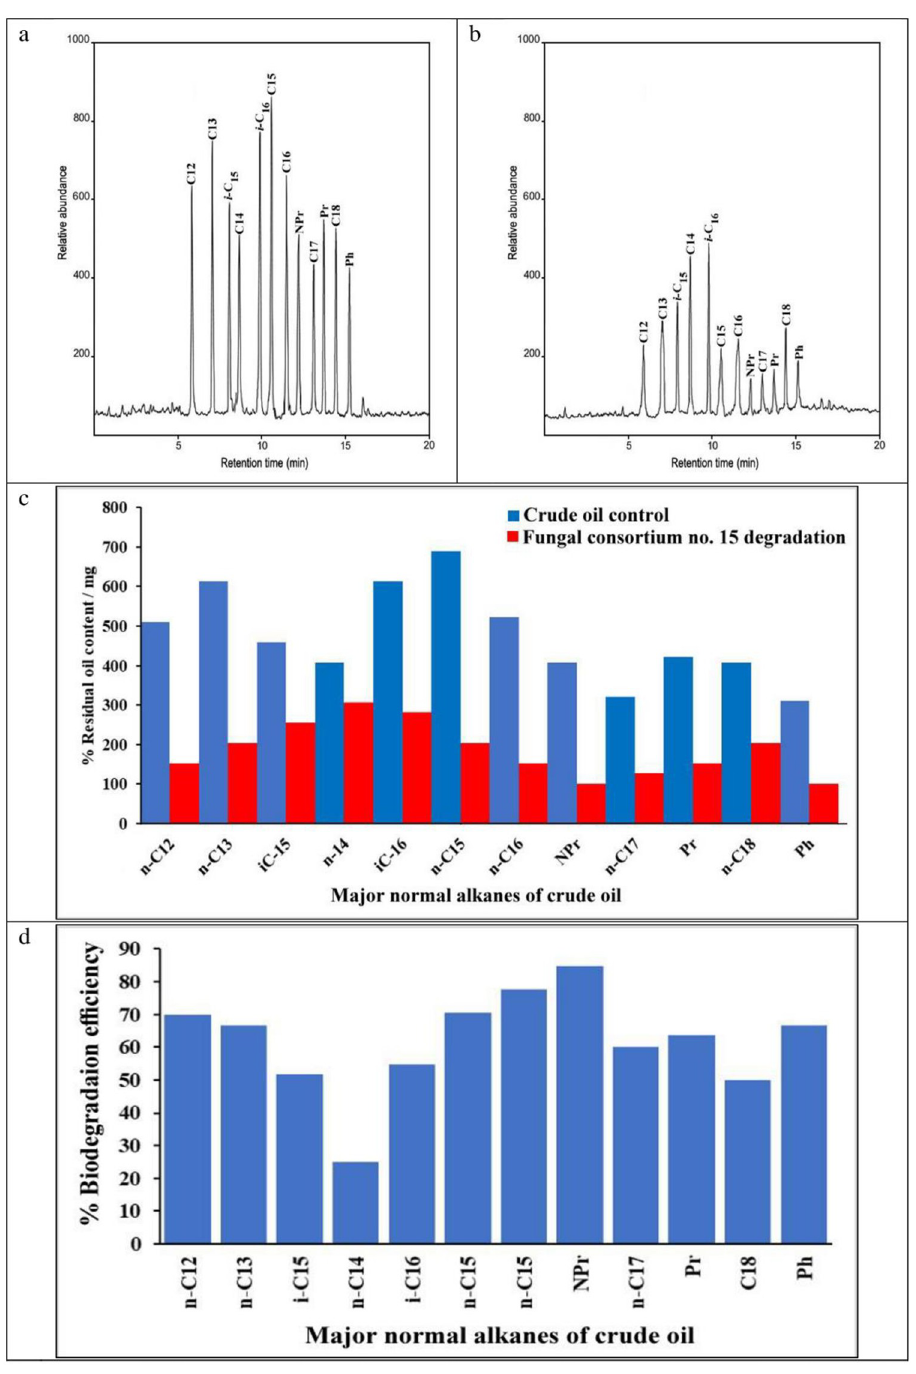
Fig 2. Normal alkanes gas chromatograms in crude oil samples before a) and after b) biodegradation by fungal consortium no. 15, c) changes of the major normal alkanes content in crude oil sample before and after biodegradation, d) biodegradation efficiency of the main normal alkanes.